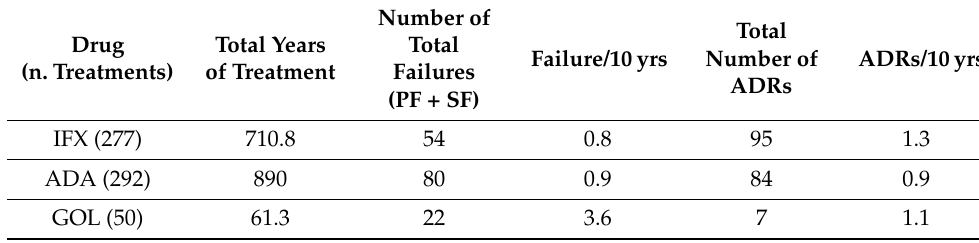
Table 4. Total years of treatment and number of failures and adverse drug reactions for each